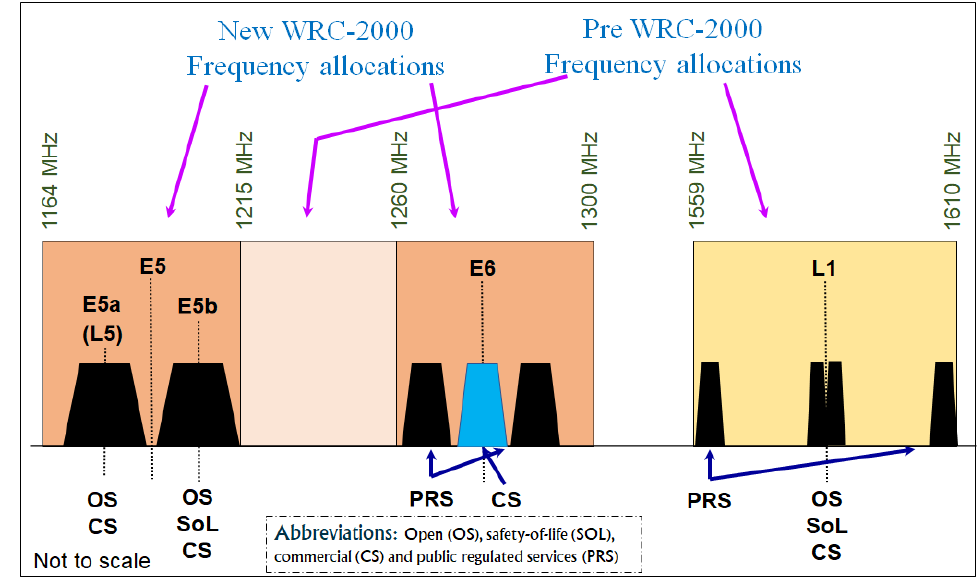
Figure 11. Overview of the Galileo signal frequencies used in commercial GNSS-based